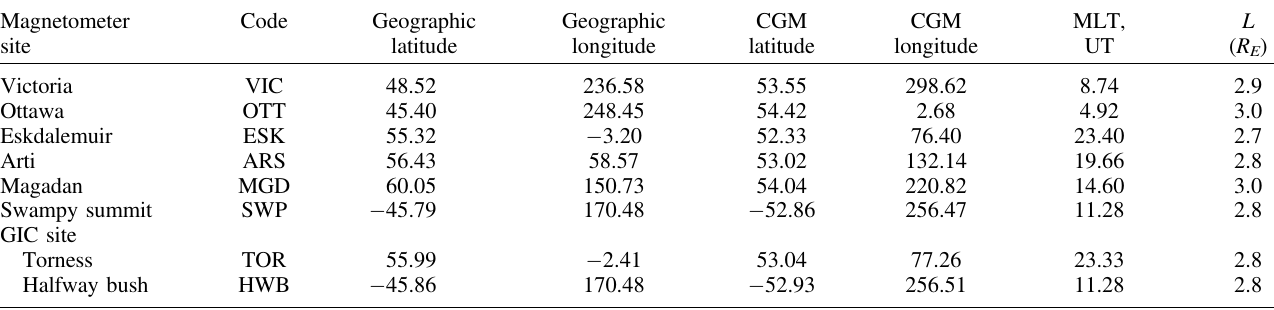
Table 1. Details of the locations, time of magnetic midnight, and L -shell of each of the magnetometer and GIC measurement sites used in this